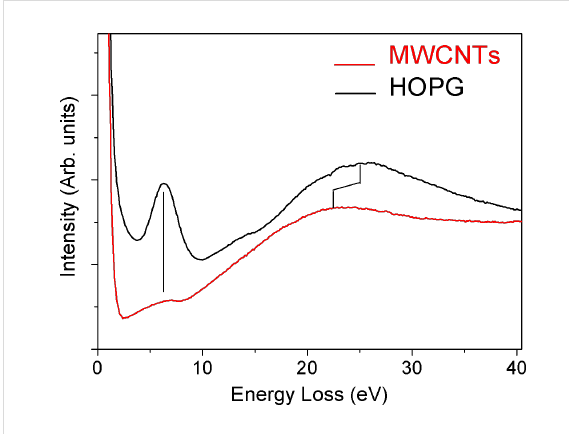
Figure 5: Energy-loss spectra of MWCNTs (red curve) and HOPG (black curve). In the case of MWCNTs, the σ + π -plasmon is shifted towards lower energy with respect to that of HOPG, located at about 26 eV, as indicated by the tick marker. The π -plasmon turns out to be sharp in HOPG (centred at 6.5 eV), whereas it is broader in MWCNTs.